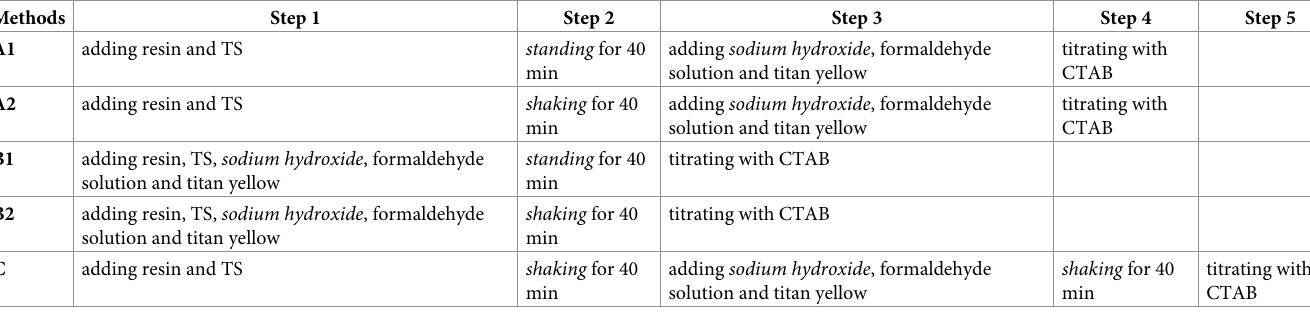
Table 1. Comparison of different detection steps in surficial N + charge density.